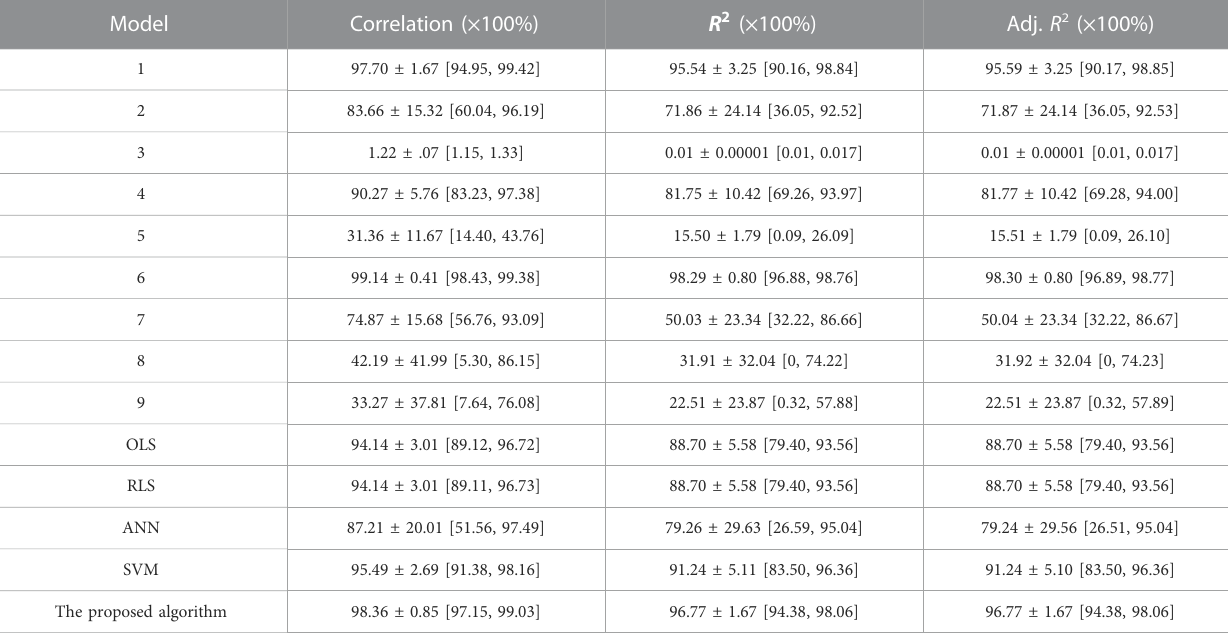
The Correlation Coef fi cient and Goodness-of- fi t measures ( R 2 and adj. R 2 ) were calculated between the reconstructed and measures force signals. Averaging was performed on fi ve